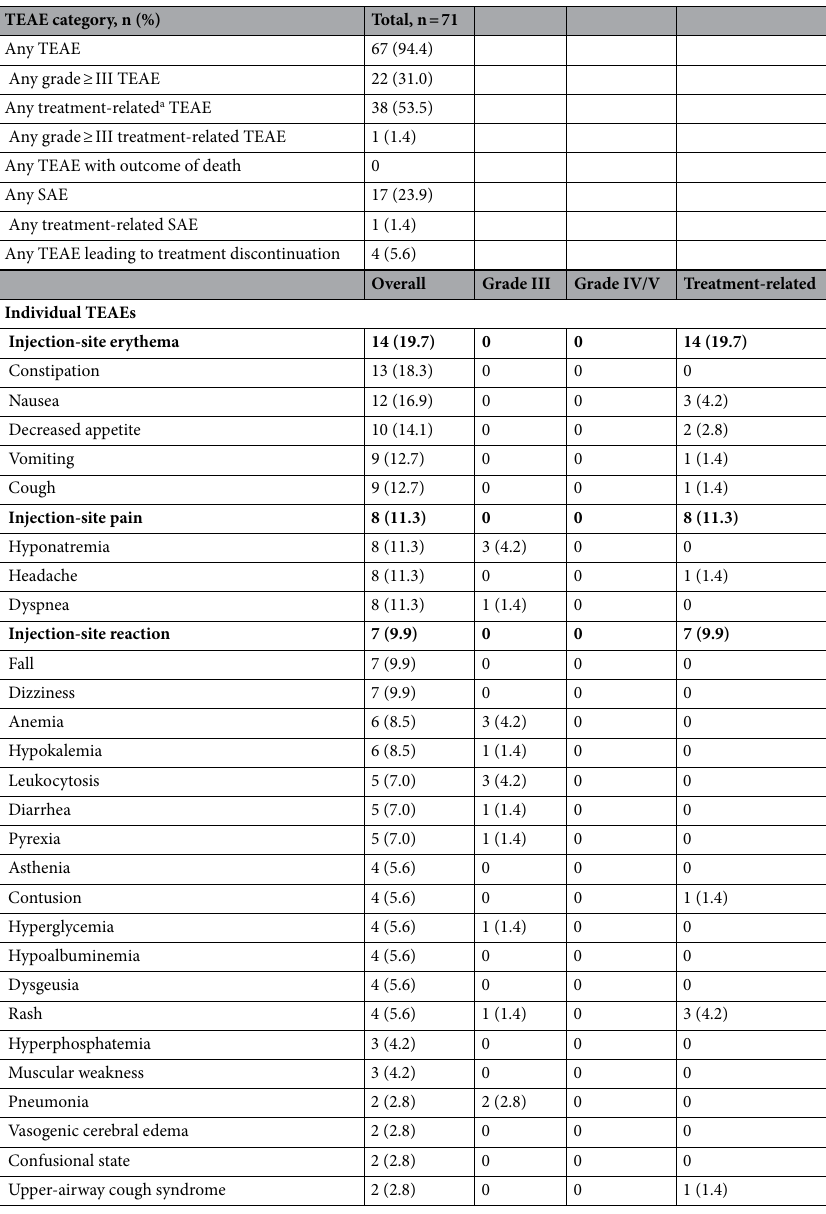
Table 2. Incidence of TEAEs. Injection-related reactions are in bold font. SAE serious adverse event, TEAE treatment-emergent adverse event. a Assessed as possibly, probably, or definitely related to study